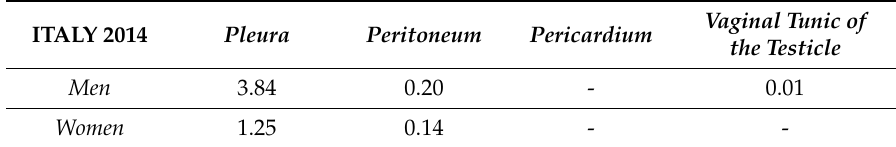
Table 7. Crude incidence rates (cases per 100,000 residents) Certainly, probable, and possible malignant